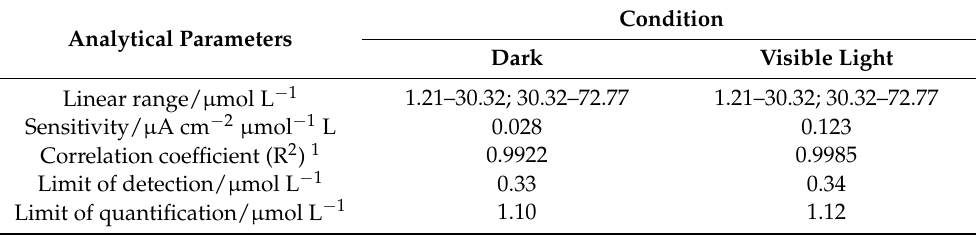
Table 3. Analytical parameters for the chronoamperometric detection of dopamine, using the ITO/FeVO(I) electrode obtained by the SILAR process (five layers).